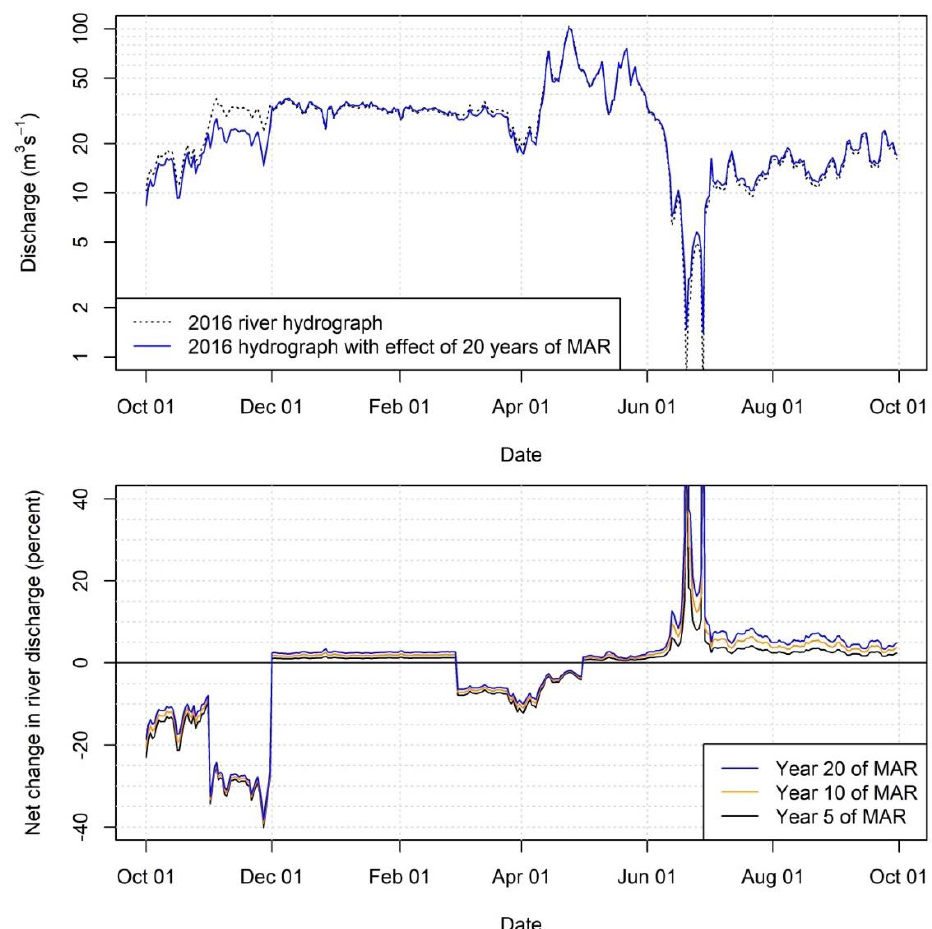
Figure A3. Net change in streamflow in a dry year for annual scenario in which diversion for MAR from the study reach is 7.3 Mm 3 per month in each of March, April, and October, and 25.6 Mm 3 per month in November. Top panel shows the 2016 water-year hydrograph and hypothetical effect of MAR implemented 20 years prior. Bottom panel shows percent change in observed 2016 streamflow 5, 10, and 20 years after initiation of annual MAR regime, respectively.